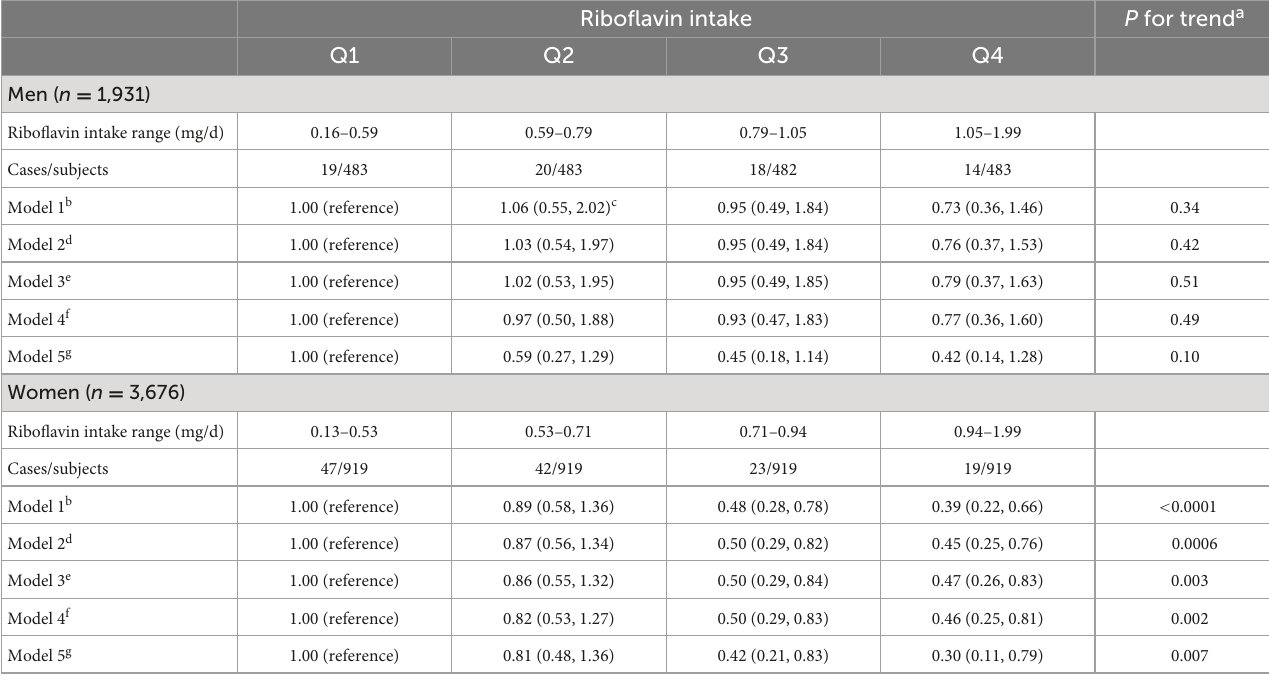
TABLE 4 Relationship between quartiles of riboflavin intake and prevalence of osteoporosis stratified by sex. Riboflavin intake P for trend